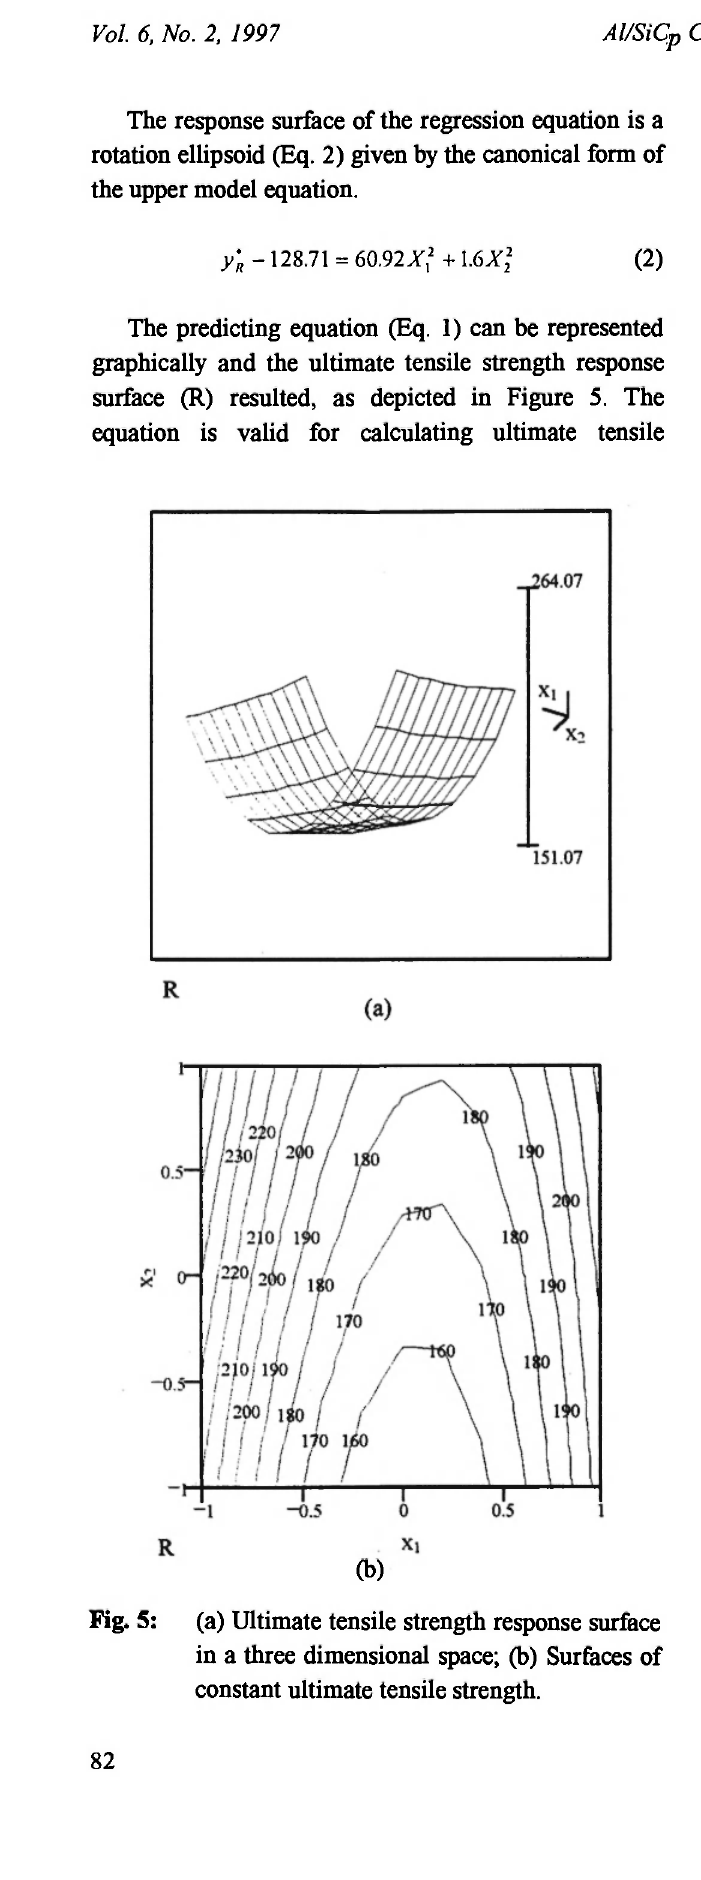
Fig. 5: (a) Ultimate tensile strength response surface in a three dimensional space; (b) Surfaces of constant ultimate tensile